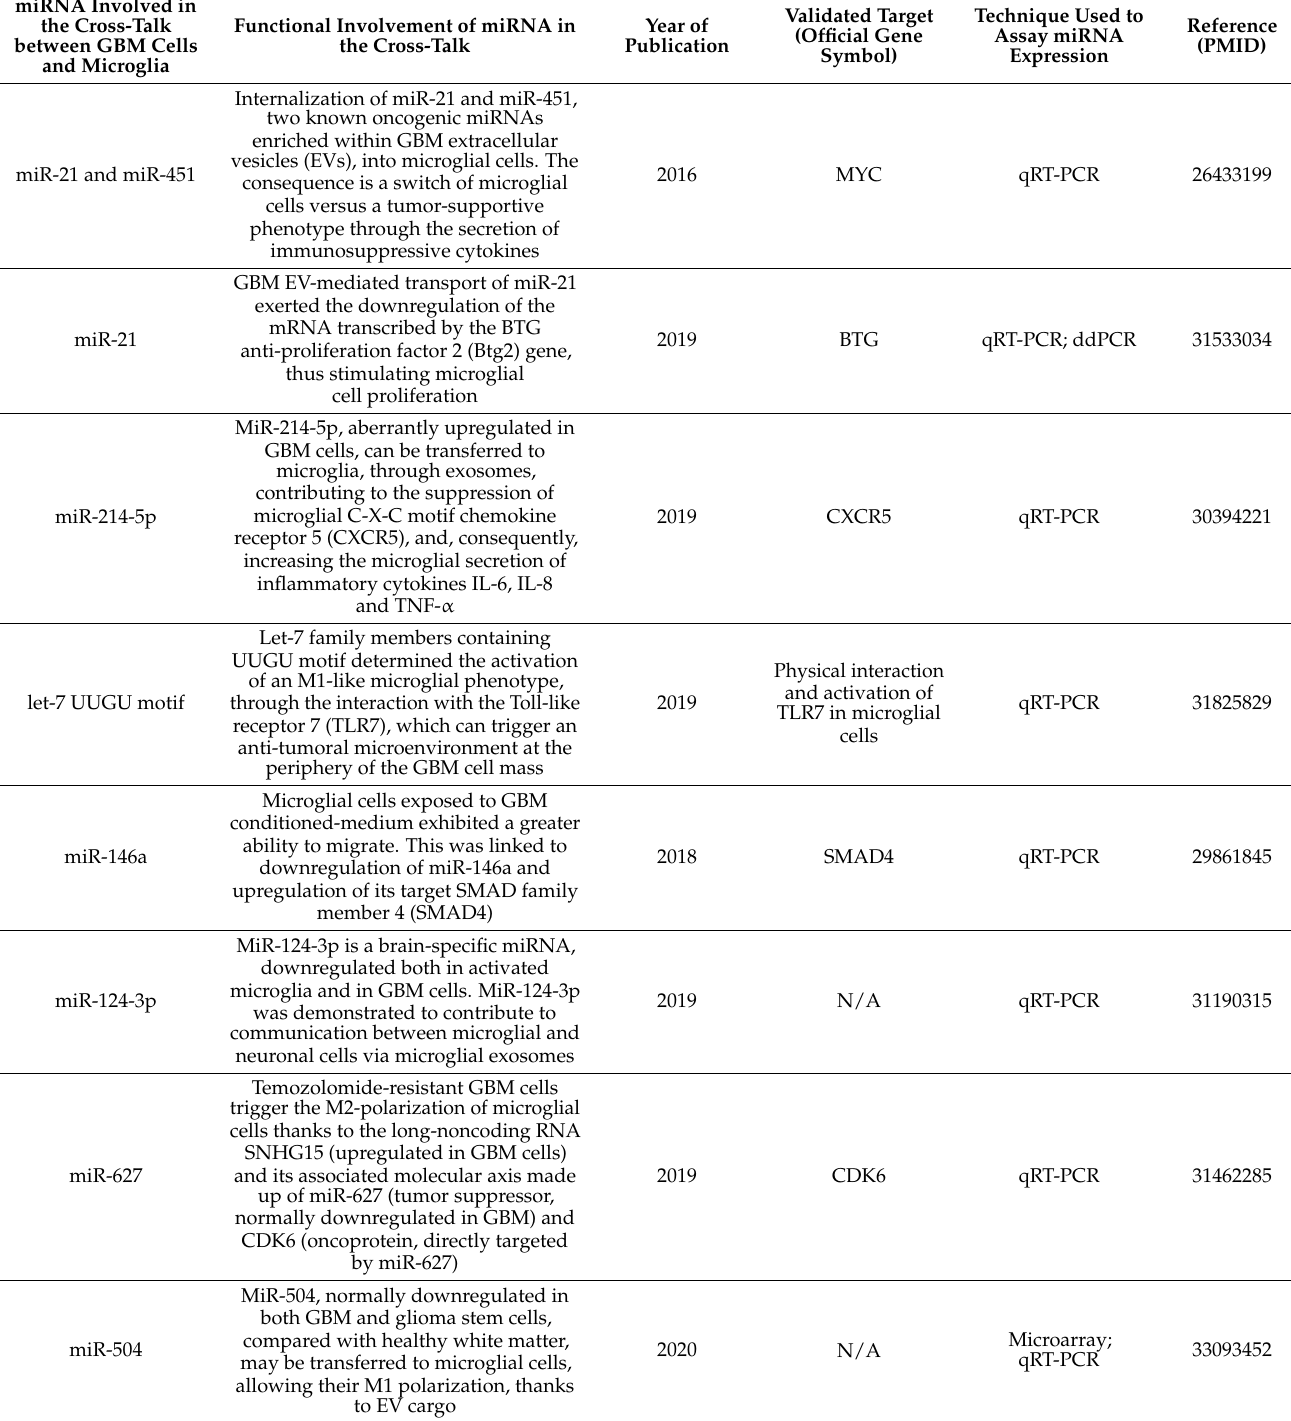
Table 2. Summary of miRNAs involved in the cross-talk between GBM and microglial cells. miRNA Involved in the Cross-Talk between GBM Cells and